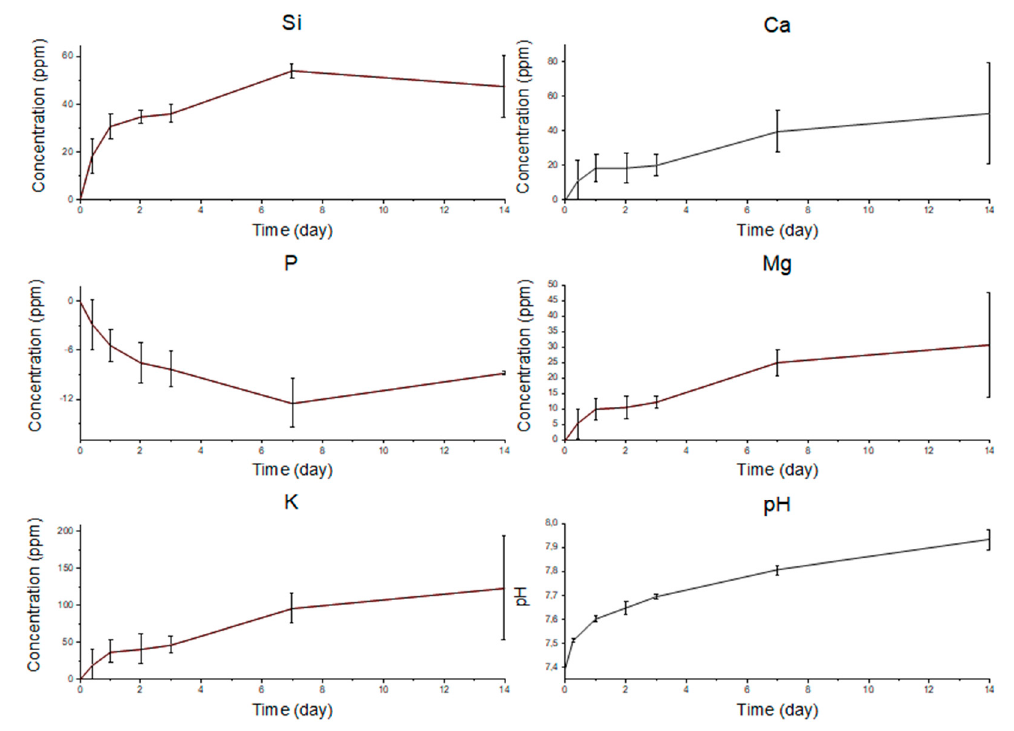
Figure 9. Ion concentration profile evolution during SBF soaking of Si, Ca, P, Mg, and K. The concentration variation was obtained by subtracting the ones of SBF blank. pH trend is also reported.